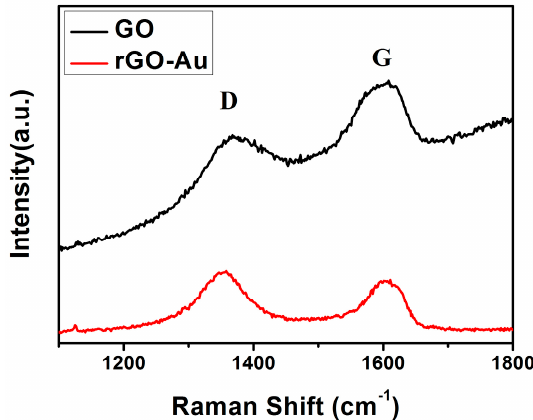
Figure 3. Raman spectroscopy of the GO (black line) and rGO/Au (red line) samples.